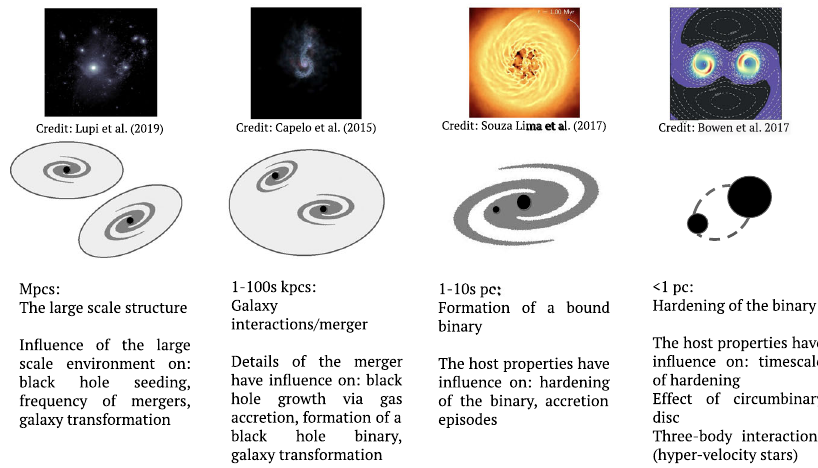
Fig. 16 A schematic view of the complex and multi-scale processes affecting the formation of a hard MBH binary system. Image credit: Silvia Bonoli and Alessandro